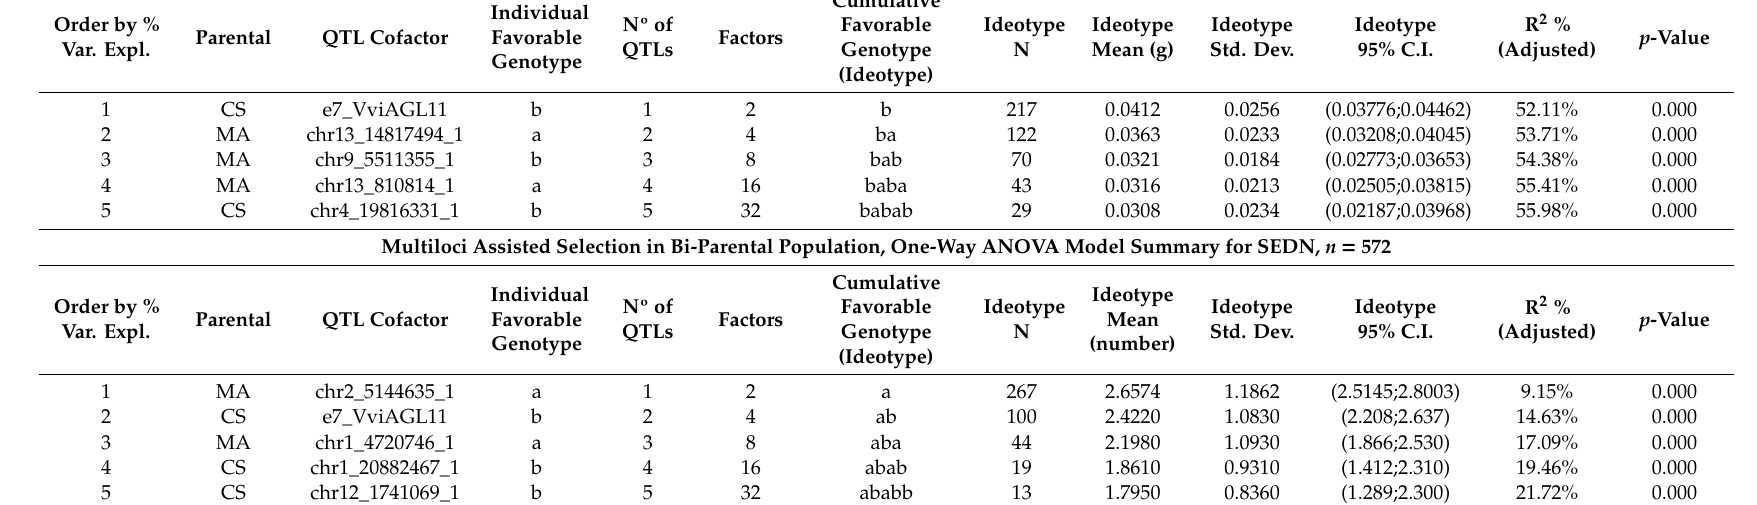
Table 2. Evaluation of a multiloci assisted selection scheme in the MA × CS experimental progeny. Multiloci Assisted Selection in Bi-Parental Population, One-Way ANOVA Model Summary for SEDW, n = 571 Order by % Var. Expl.